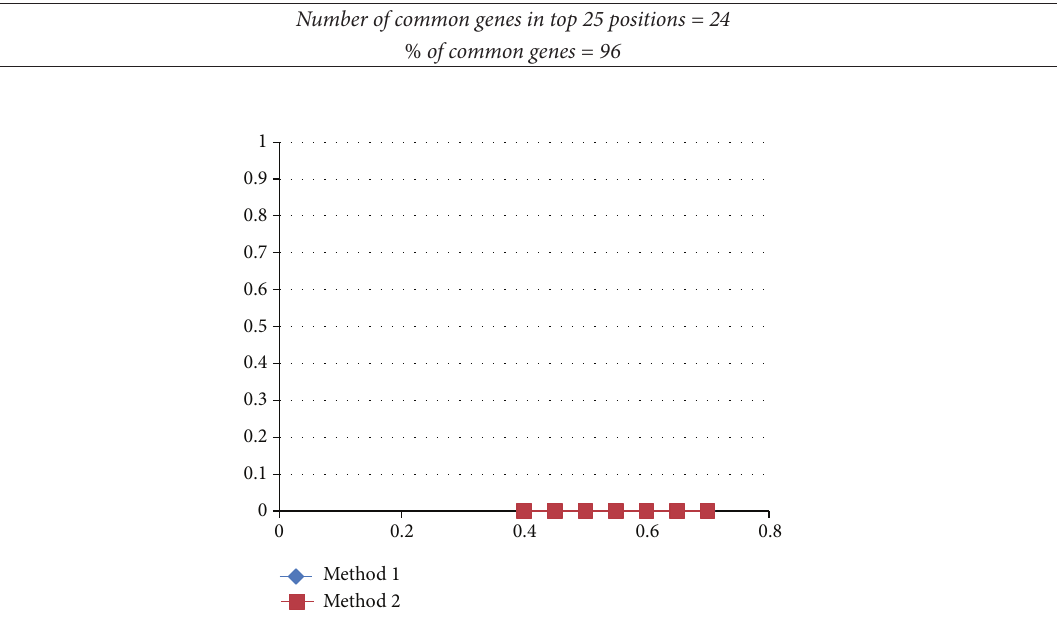
Figure 5: Plot of RMSE versus membership grade 𝜃 for elu